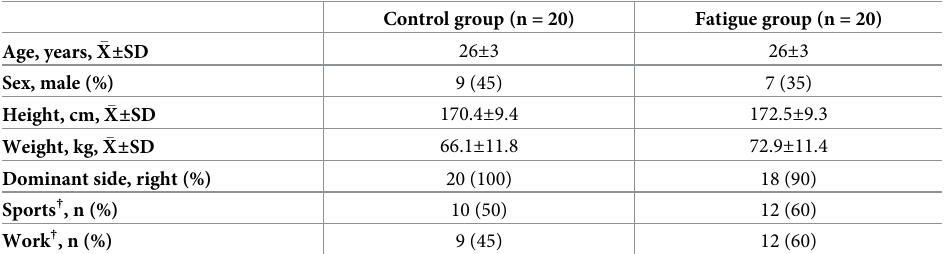
Table 1. Participant’s baseline